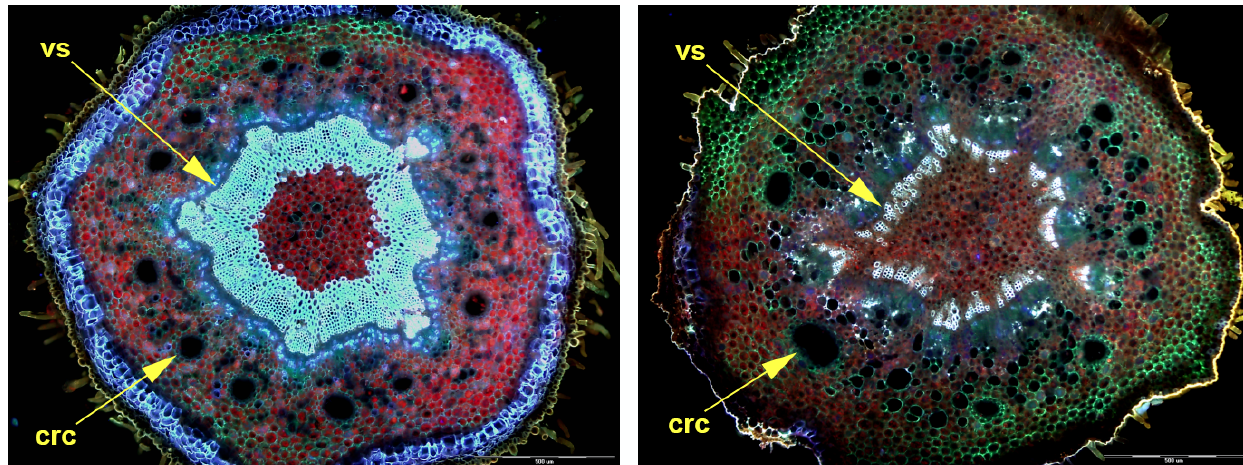
Figure 5 Two transverse handmade sections through the annual increment of the Cedrus shoot with Fibonacci phyllotaxis. On the left – bottom part of this shoot with 13 cortical resin canals (crc), on the right – the upper part with the number of canals reduced to eight. The change annunciates the vascular system (vs) reorientation. Scale bar: 500 µ